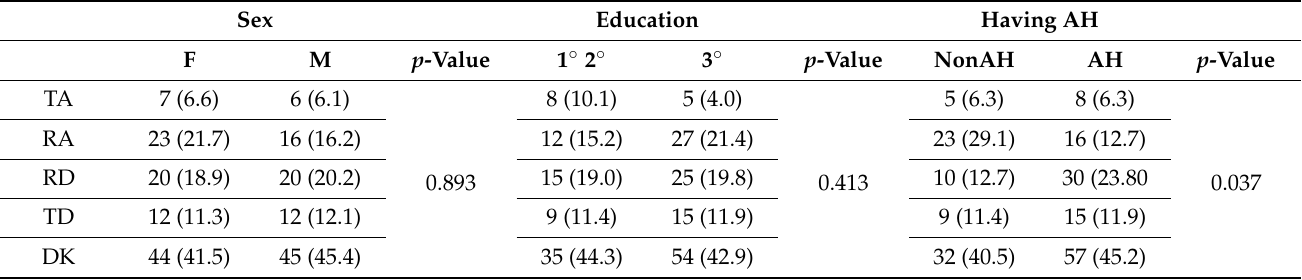
Table 8. Shift work as a factor that increases the incidence of hypertension by gender, education, and having hypertension (N = 205).